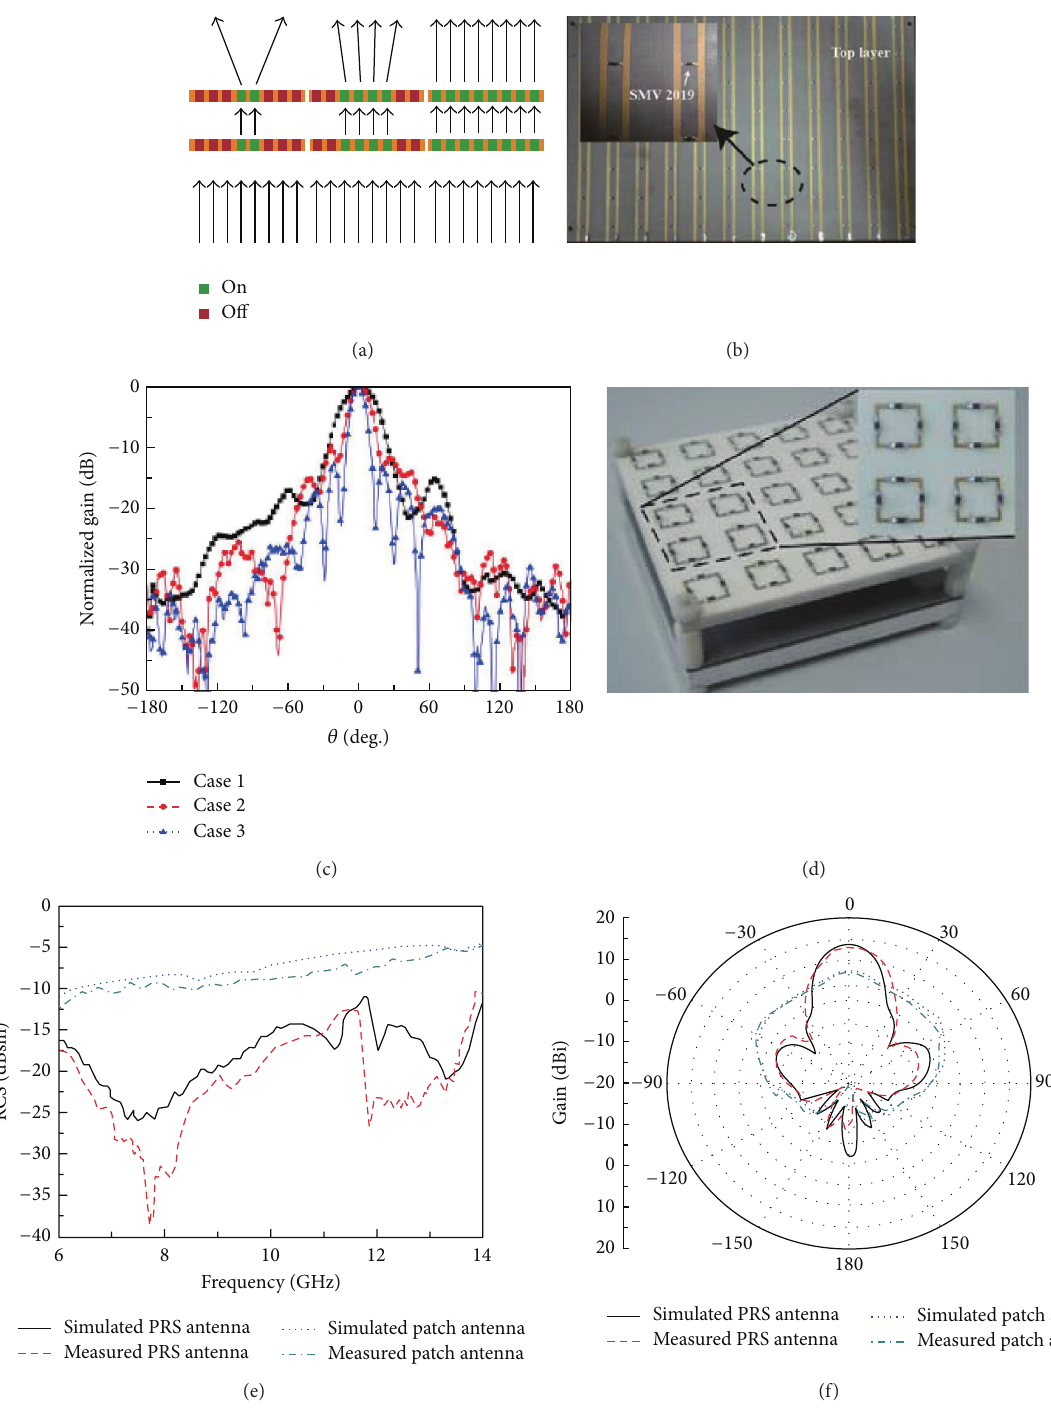
Figure 44: (a) Schematic of the beamwidth controlling using metasurface. (b) Photographs of the fabricated FSS for beamwidth controlling. (c) Response of reflection and transmission coefficients to different capacitance values at the interesting frequency region. (d) Photograph of the low RCS antenna loading partially absorbing metasurface. (e) The RCS results for the PRS antenna with and without PRS. (f) Measured 𝐸 -plane far-field patterns for the beamwidth manipulation antenna at 5.5 GHz. Figures are reproduced from